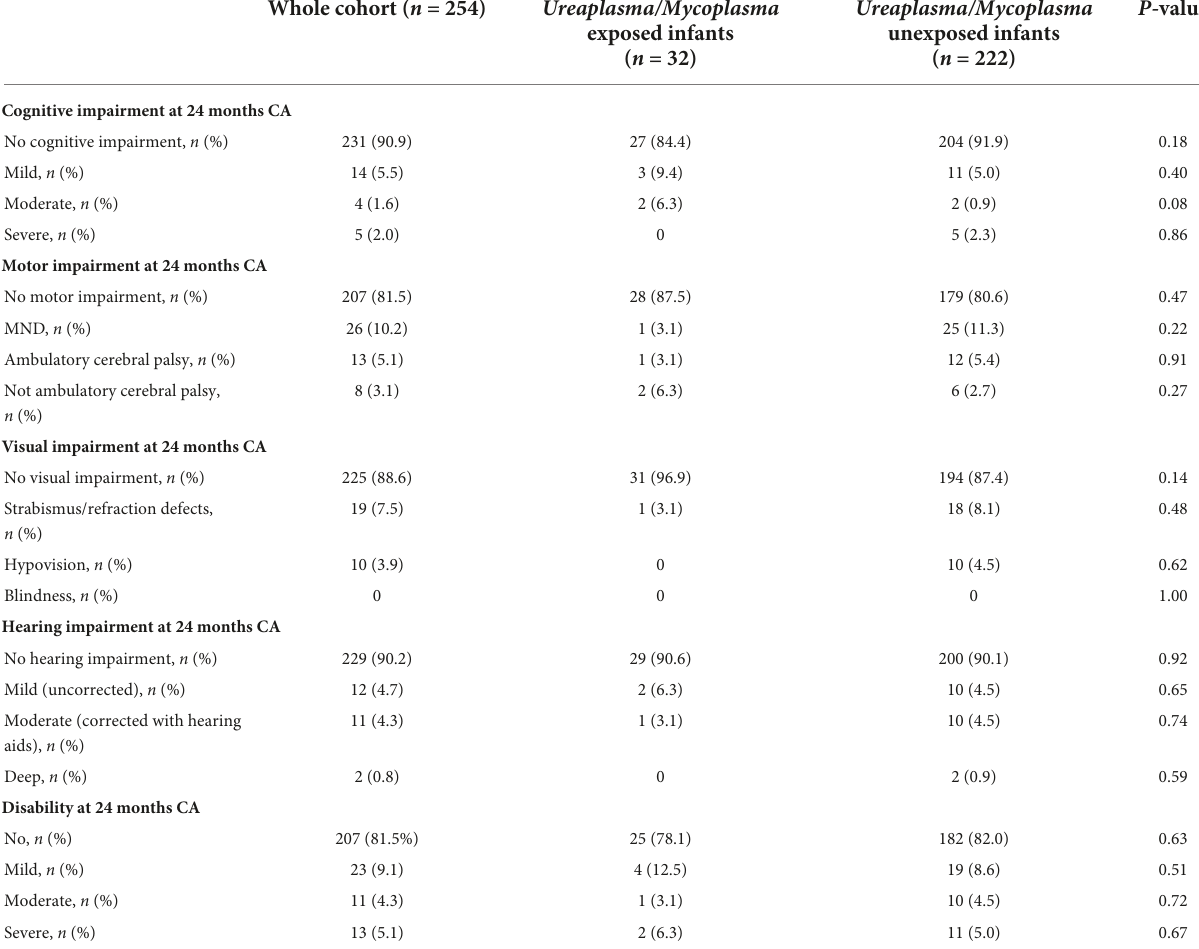
TABLE 2 Neurodevelopmental outcomes at 24 months CA in exposed and unexposed infants to U./M . colonization during pregnancy. Whole cohort ( n = 254) Ureaplasma/Mycoplasma